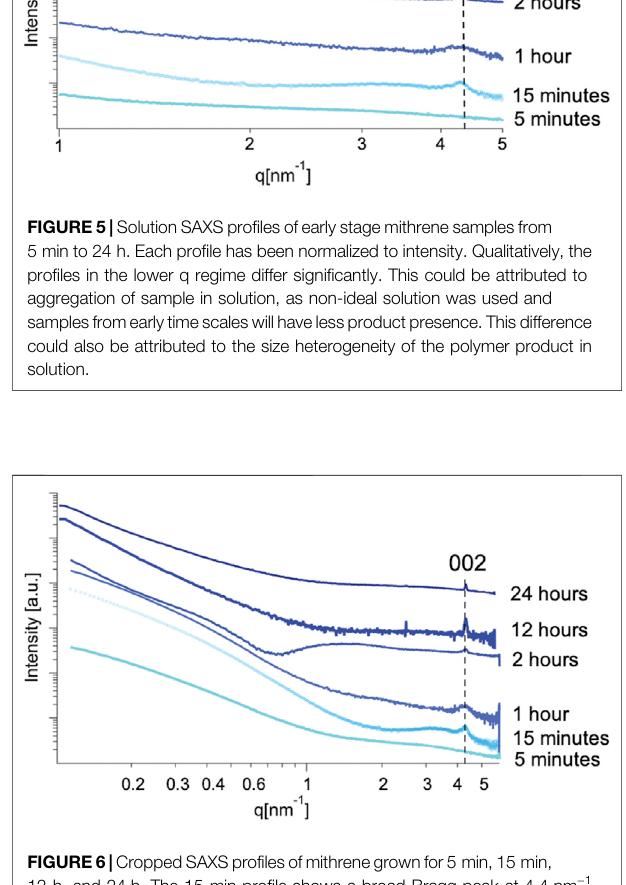
FIGURE6| CroppedSAXSprofilesofmithrenegrownfor5 min,15 min, 12-h, and 24 h. The 15-min pro fi le shows a broad Bragg peak at 4.4 nm − 1 which corresponds well with the known interlayer spacing of mithrene crystallites and the (002) crystallographic plane, the 24-h pro fi le shows a sharperpeak also correspondingwiththe (002) crystallographicplane, aswell as the 12-h pro fi le and the 5-min pro fi le shows a complete absence of the